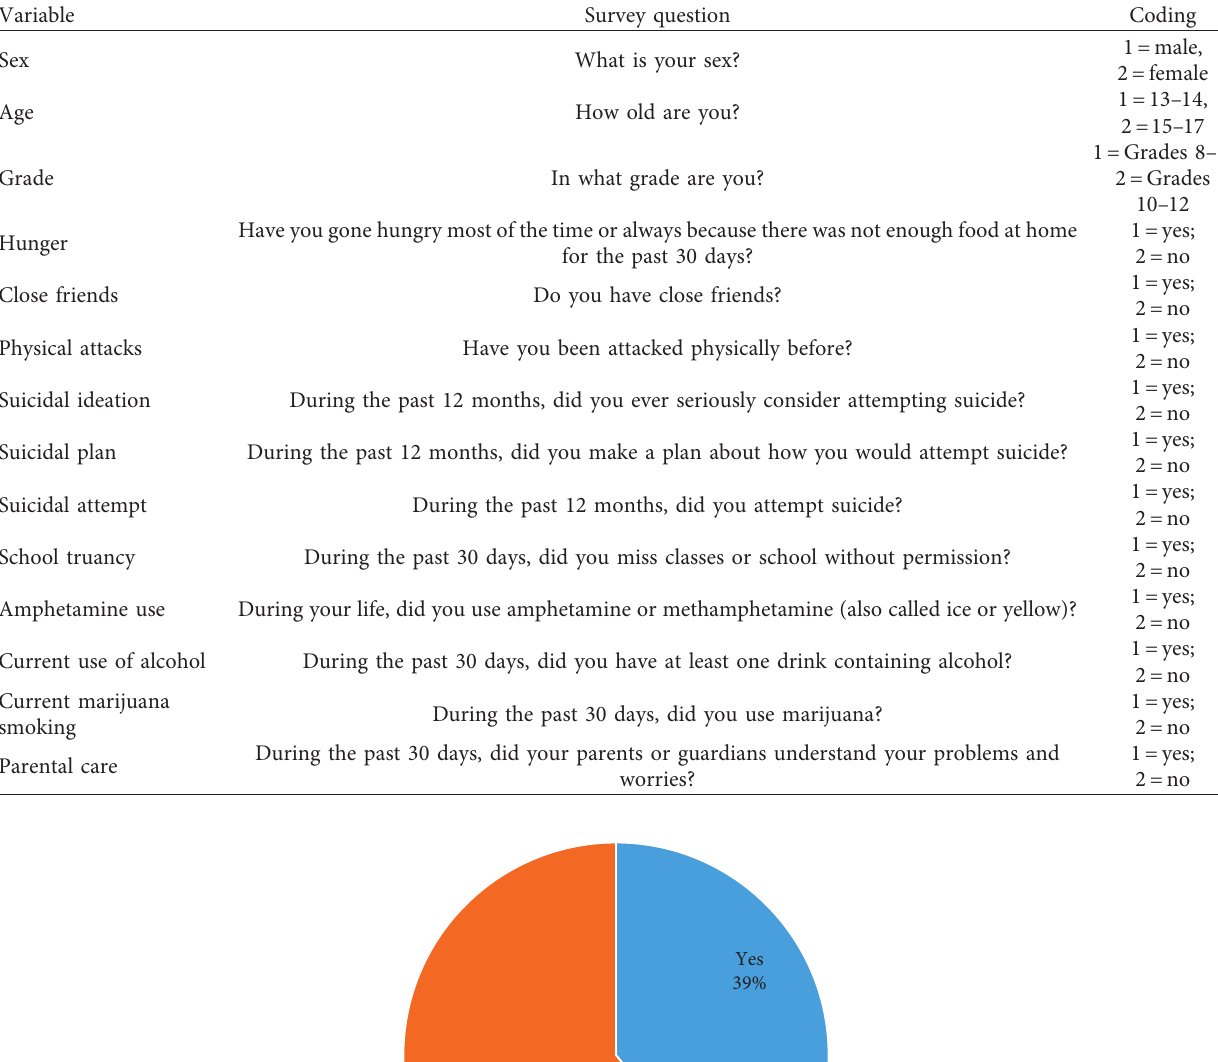
Table 1: Definition of explanatory and measurement coding of variables.